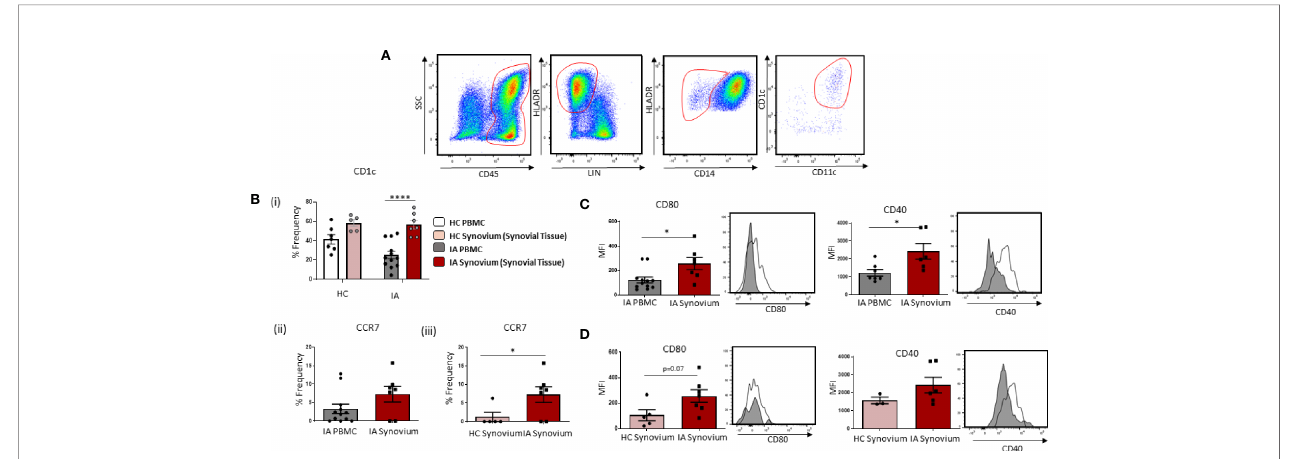
FIGURE 2 | Accumulation of Mature CD1c + DCs in IA Synovial Tissue. (A) Gating strategy to identify CD1c + DCs in IA synovial tissue. Following the elimination of debris, doublets, and dead cells, cells were gated as CD45 + Lineage – HLADR + CD14 − CD11c + CD1c + . (Bi) The percentage frequency of CD1c + DCs in HC PBMC (n = 7), HC synovial tissue (n = 5), IA PBMC (n = 12), and IA synovial tissue (n = 7). CD1c + DC frequency is represented as a percentage of cells in the mDC gate. (Bii) The percentage frequency of CCR7 + CD1c + DCs in IA PBMC (n = 12) and IA synovial tissue (n = 7). (Biii) The percentage frequency of CCR7 + CD1c + DCs in HC synovial tissue (n = 5) and IA synovial tissue (n = 7). (C) MFI of CD80 and CD40 expression on CD1c + DCs from IA PBMC (n = 7 – 12) and IA synovial tissue (n = 6 – 7). (D) MFI of CD80 and CD40 expression on CD1c + DCs from HC synovial tissue (n = 3 – 5) and IA synovial tissue (n = 6 – 7). Non-parametric unpaired Mann Whitney test was used. Where multiple comparisons were determined, two-way ANOVA was used. *p < 0.05, **p < 0.01, ****p < 0.0001 indicate groups that are signi fi cantly different from each